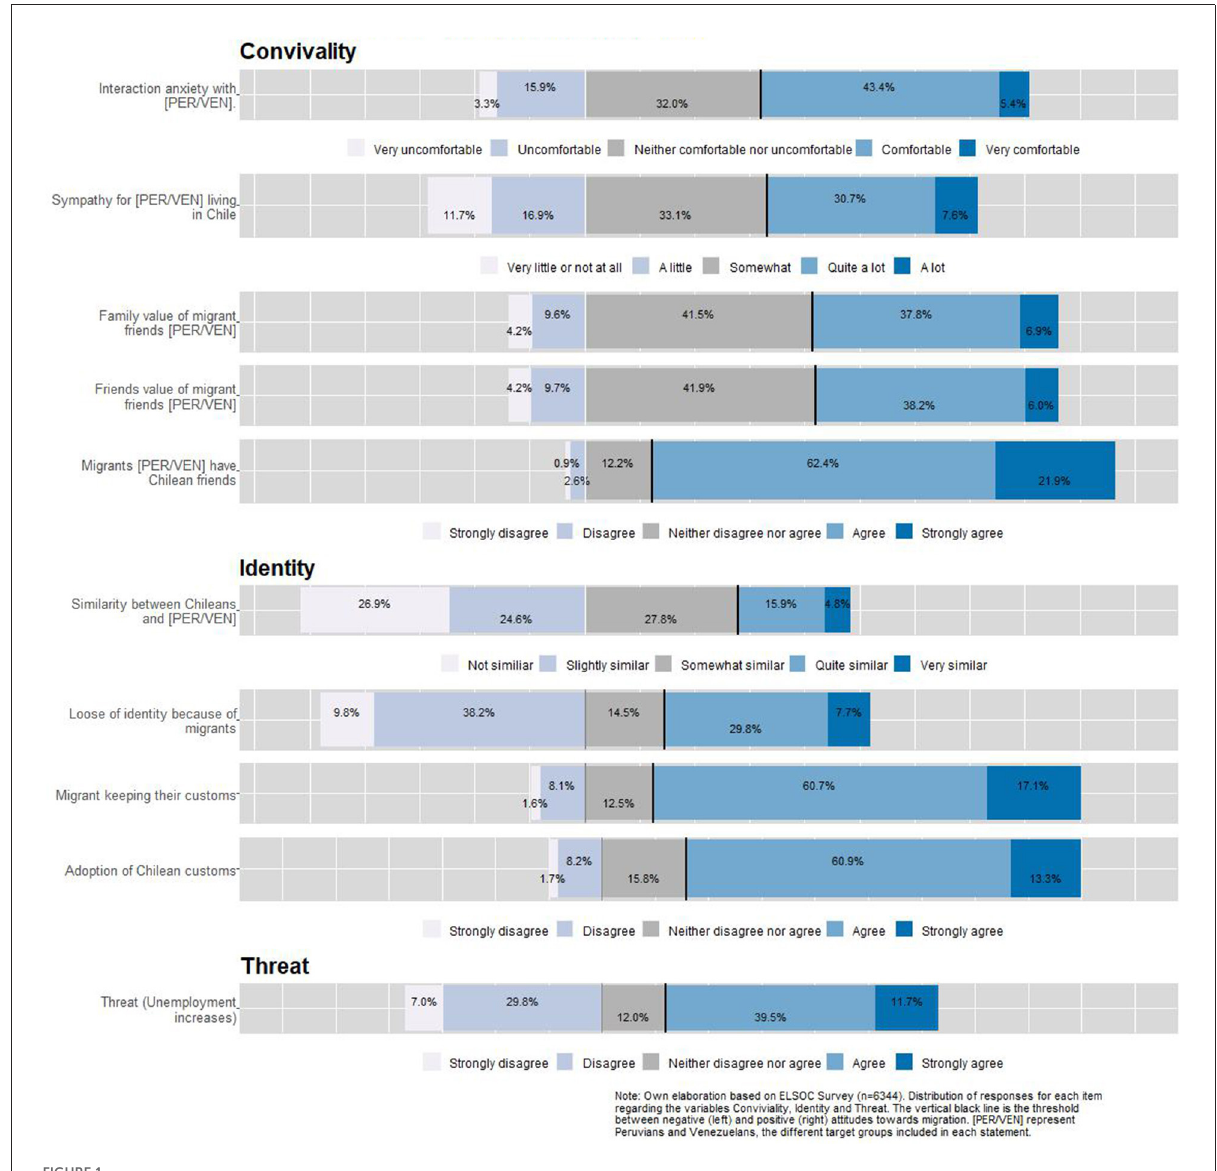
FIGURE1 Frequencies for convivial/conviviality, identity, and threat